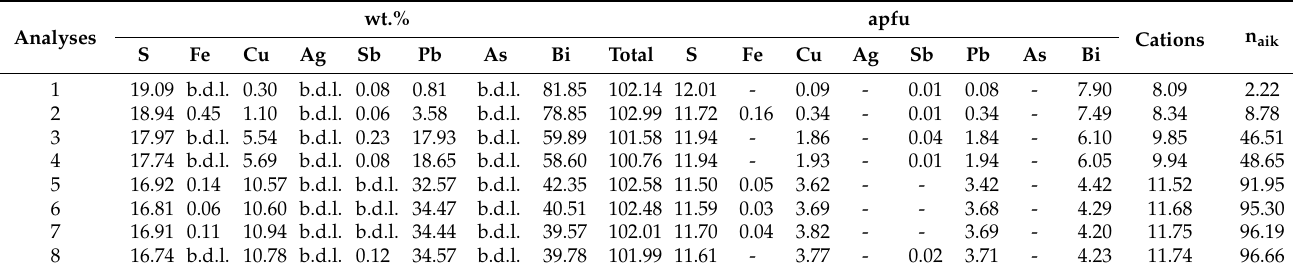
Table 1. Representative EPMA data for members of bismuthinite-aikinite series: bismuthinite [1,2], krupkaite [3,4], and aikinite [5–8] from Kizhnica quarry. The empirical formula was calculated based on the sum Ag + Bi + Sb + Fe + As + (Pb + Cu)/2 = 8 atoms, b.d.l. = below detection